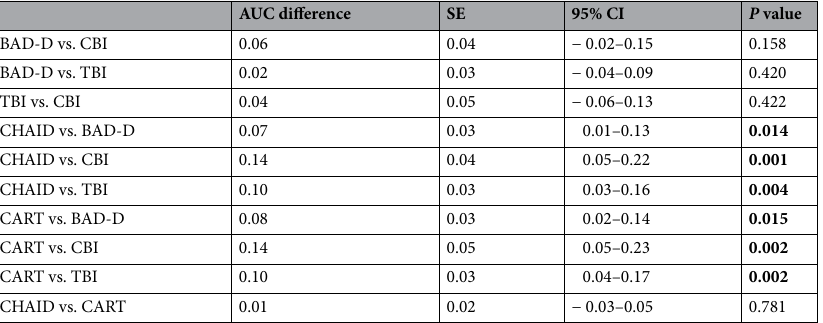
Table 4. Delong’s test results of major predictors’ AUCs for NE vs. SKC. BAD-D Belin/Ambrósio Enhanced Ectasia Display Index, CBI corvis biomechanical index, TBI combined tomography and biomechanical index, CHAID CHAID model based on training database, CHAID CART model based on training database. Significant values are in